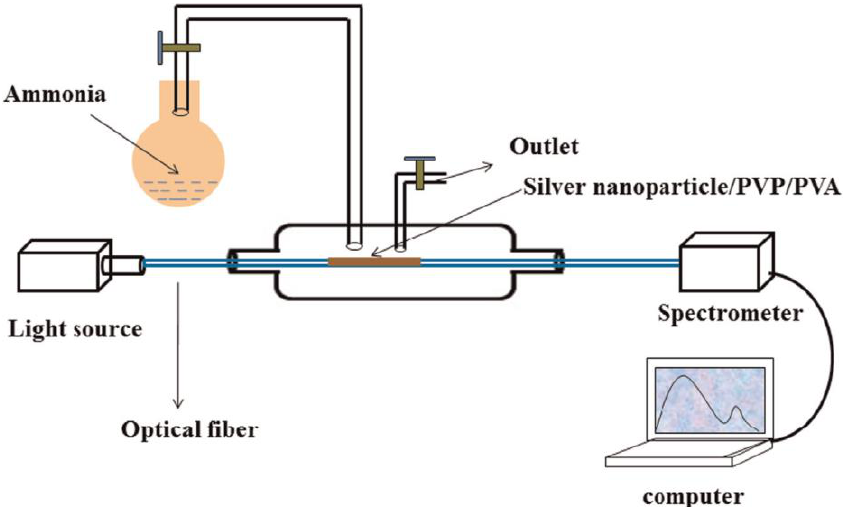
Figure 12. Schematic representation of the experimental setup of the ammonia sensor. Reprinted from [46], with permission from Elsevier. from [45], with permission from